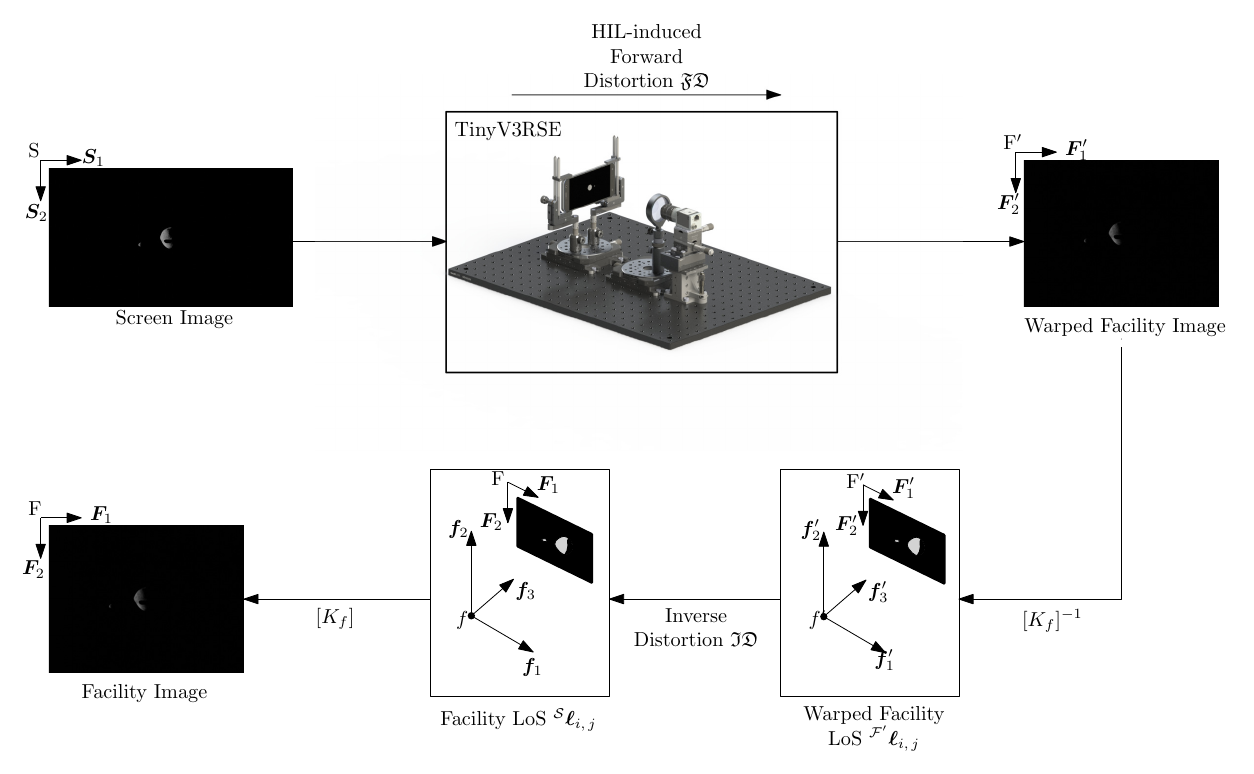
Figure 12. Downstream